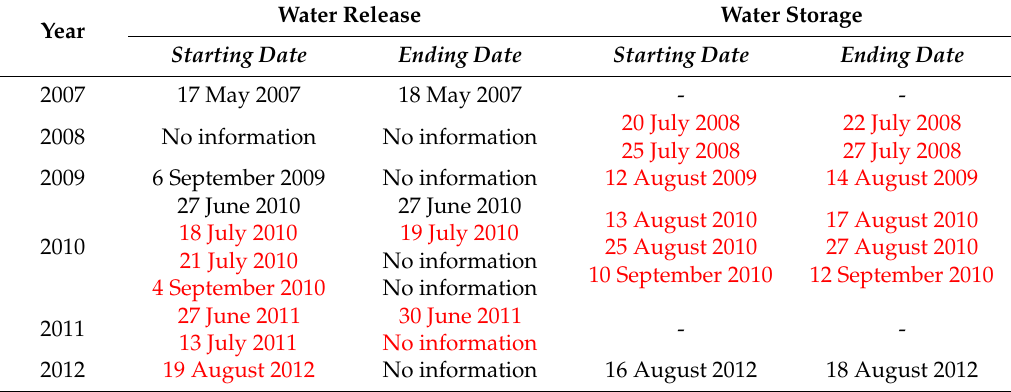
Table 2. Durations of water release and water storage in Hwanggang dam (The red letters express the durations where dam operation a ff ected the simulation